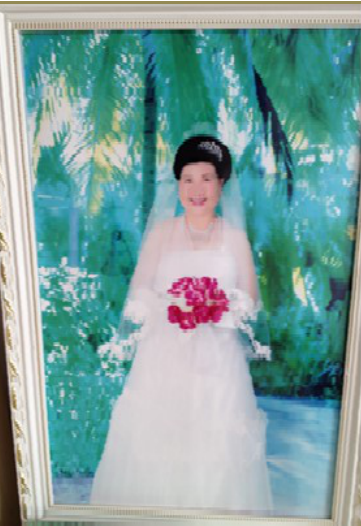
Reform-era wedding photo. Photo: Jeanne